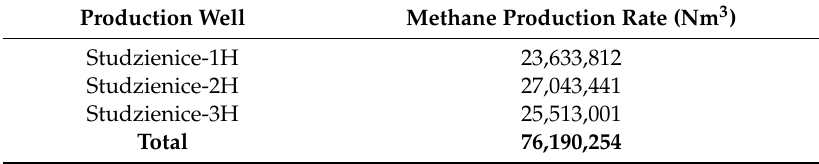
Table 8. Rates of methane production for the particular wells.